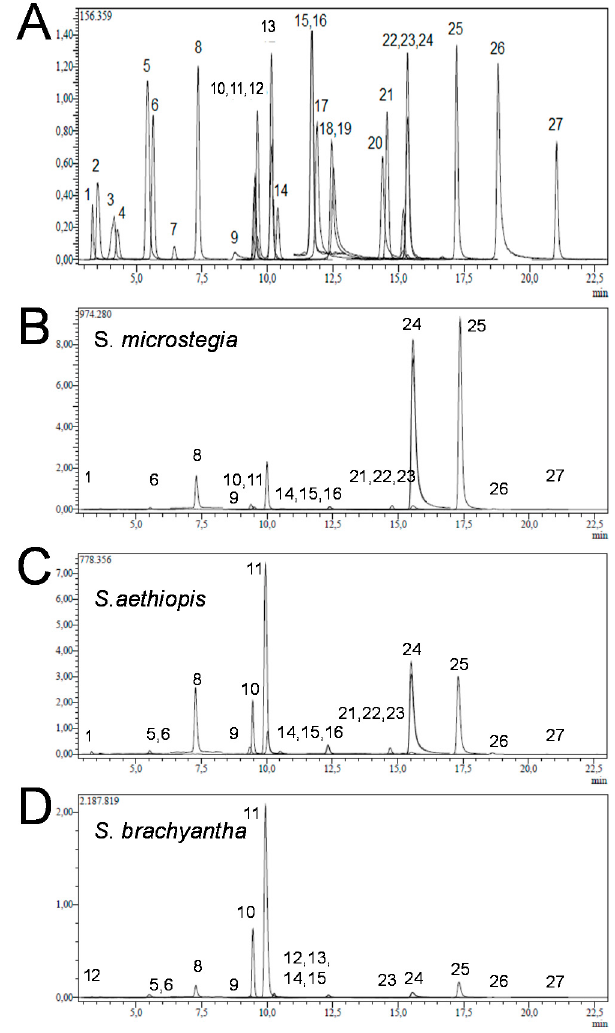
Figure 1. Typical HPLC chromatograms of ( A ) standards; ( B ) S. microstegia ; ( C ) S.aethiopis ; and ( D ) S. brachyantha where (1) is quinic acid, (5) chlorogenic acid, (8) trans-caffeic acid, (9) vanillin, (10) p -coumaric acid, (11) rosmarinic acid, (15) 4-hydroxybenzoic acid, (16) salicylic acid, (24) kaempferol and (25) apigenin. (For all compounds see Table 1).